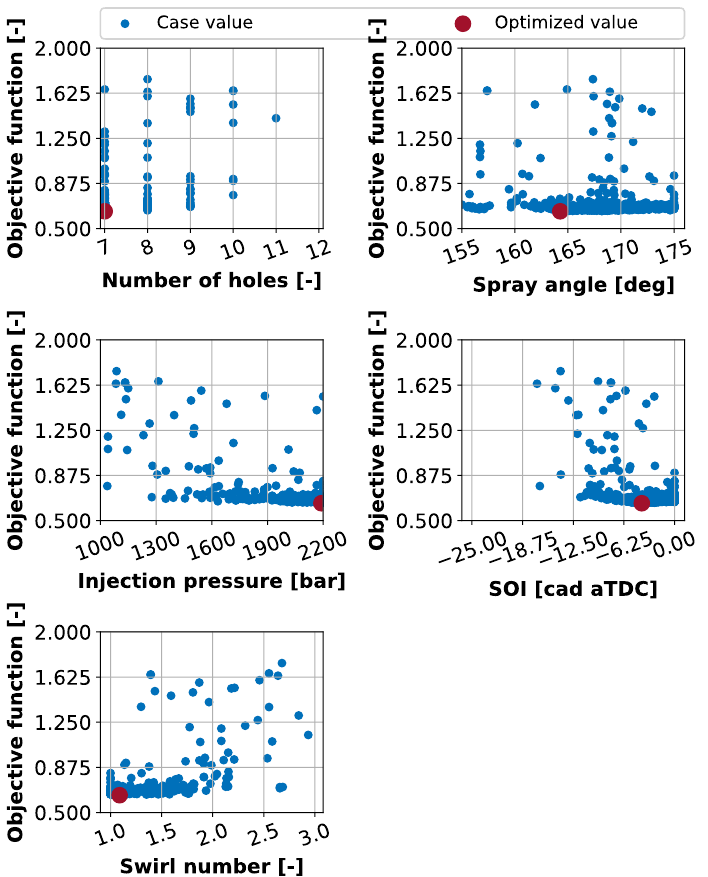
Figure 10. Objective function value for inputs of the injection system and swirl number. The plots in Figure 11 corroborate the fact that the best case (the red dot with the minimum objective function), is obtained for the lowest soot level and the maximum efficiency, which were the objectives of the optimization process. Also, the constraints are respected, with a high reduction of CO emissions, associated with the maximum efficiency trend.